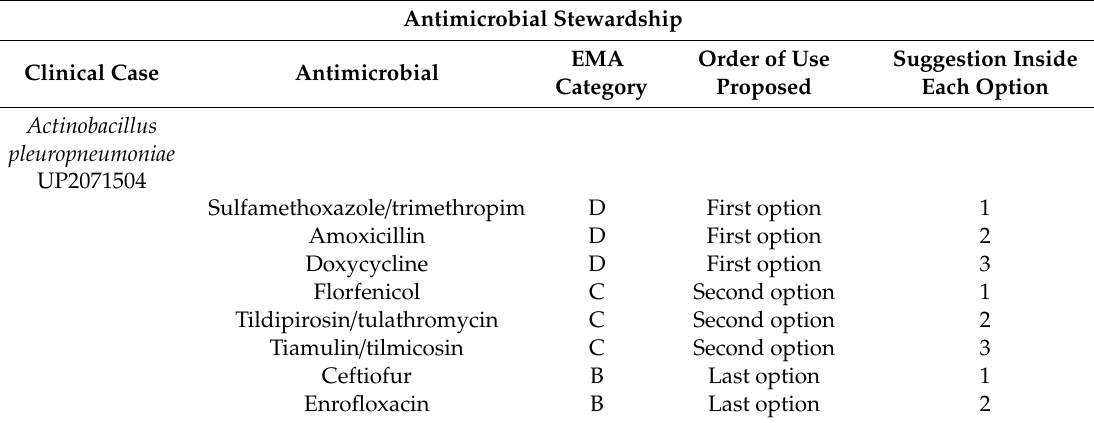
Figure 3. Antimicrobial susceptibility pattern and a pharmacological recommendation based on MIC results, clinical breakpoints available [15], and EMA categorization of antimicrobials [6] are detailed for the case of report 1. It is included the current case and three former APP cases coming from the same sow origin. More information is available in Supplementary Material S1. Table 3. Antimicrobial stewardship for an Actinobacillus pleuropneumoniae strain isolated in a clinical case with reference report 1.